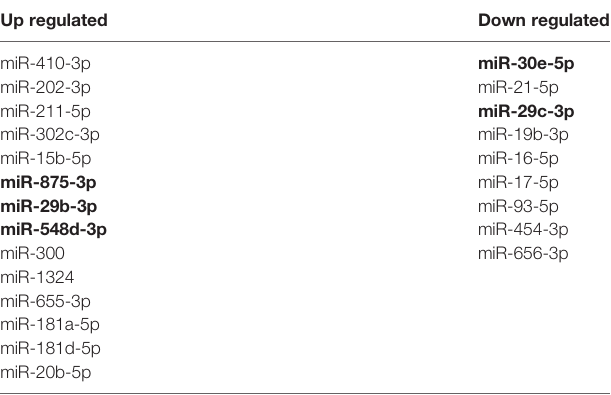
TABLE 2 | Set of miRNAs signi fi cantly expressed both in in vitro and ex vivo contexts. Up regulated